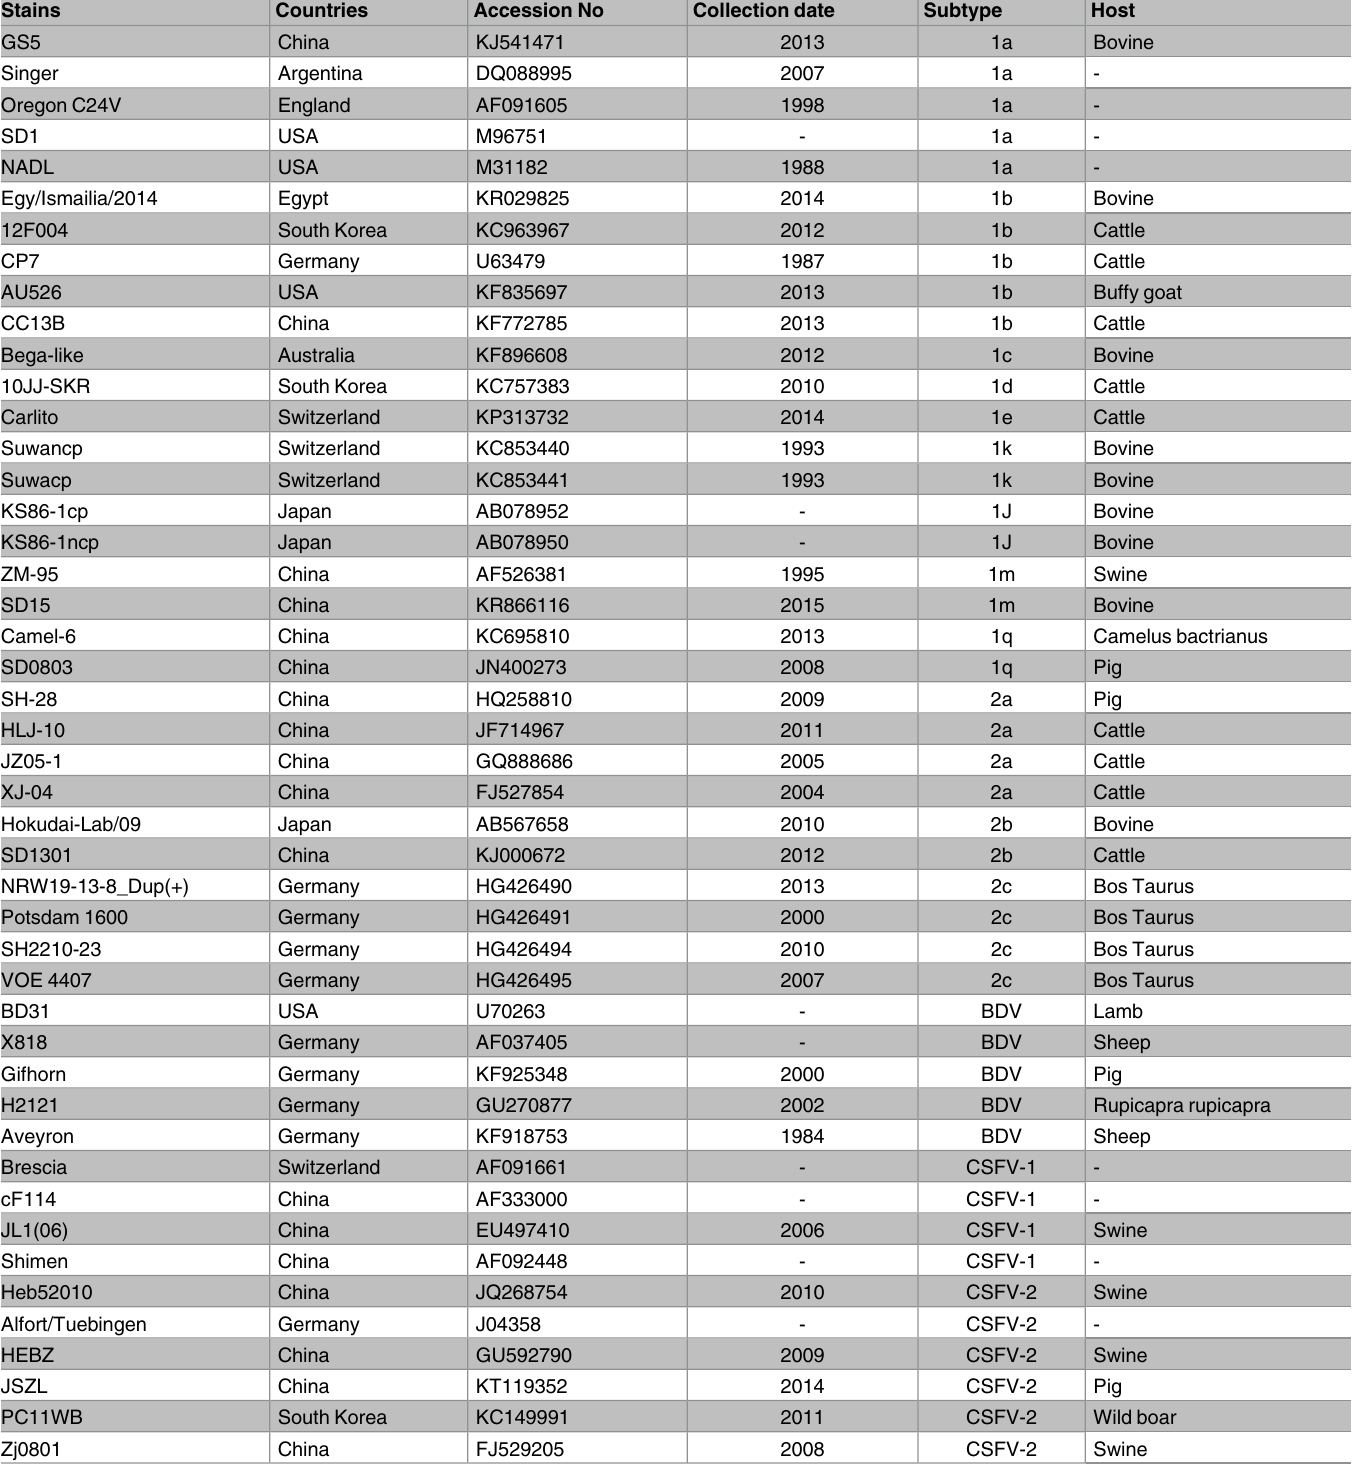
Table 3. The pestivirus strain used for alignment and phylogenetic